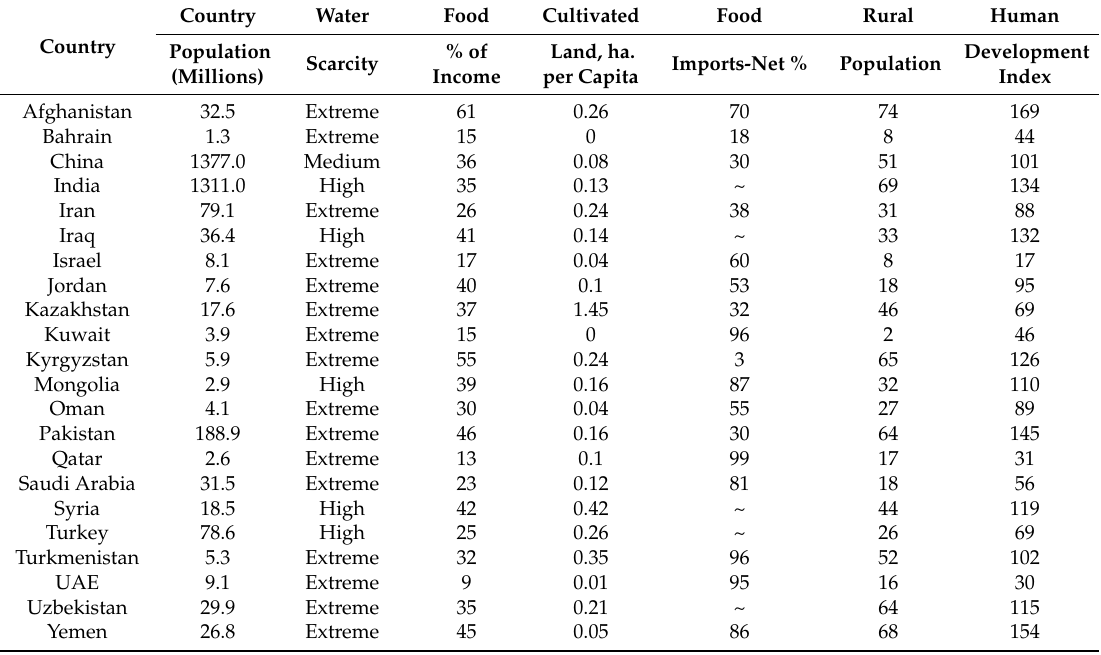
Table 3. Socio-economic factors that frame climate hazard risk in Asian drylands. Country Water Food Country Population (Millions)